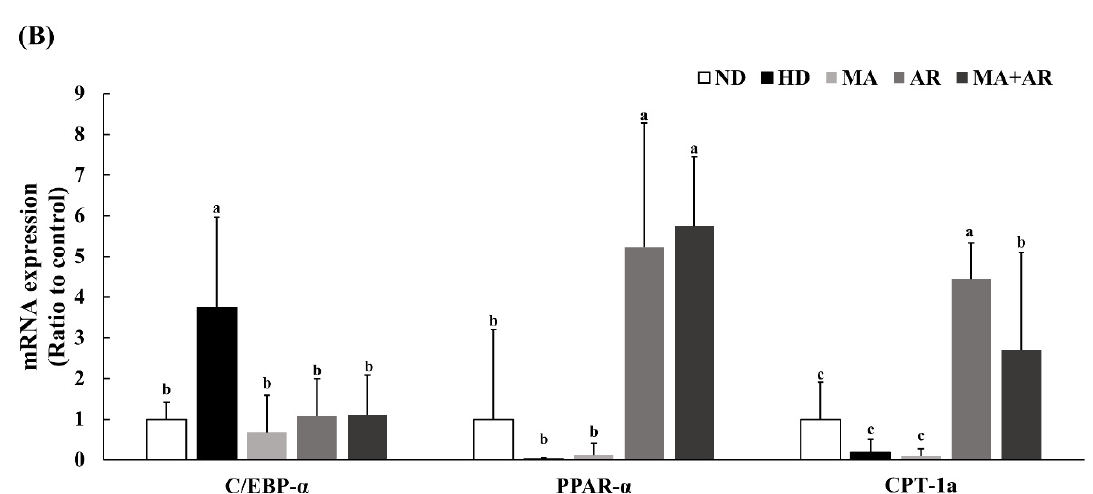
Figure 5. mRNA expression of genes related to lipid metabolism in liver and adipose tissue of the experimental mice. M. alba extract (400 mg/kg bw), A. melanocarpa extract (400 mg/kg bw), or mixture of these two extracts was orally administered to experimental mice fed a high-fat diet for 14 weeks. ( A ) Relative mRNA expression in liver, ( B ) relative mRNA expression in adipose tissue. ND, normal diet, HD, high-fat diet, MA, high-fat diet + M. alba 400 mg/kg bw, AR, high-fat diet + A. melanocarpa 400 mg/kg bw, MA + AR, high-fat diet + mixture of M. alba and A. melanocarpa (400 mg/kg bw). Results are expressed as means ± S.D ( n = 10). Means with different superscript letters (a, b, c, d) are significantly different from each other by Duncan’s test of ANOVA at p < 0.05. “a” denotes the highest value and “d” represents the lowest value.